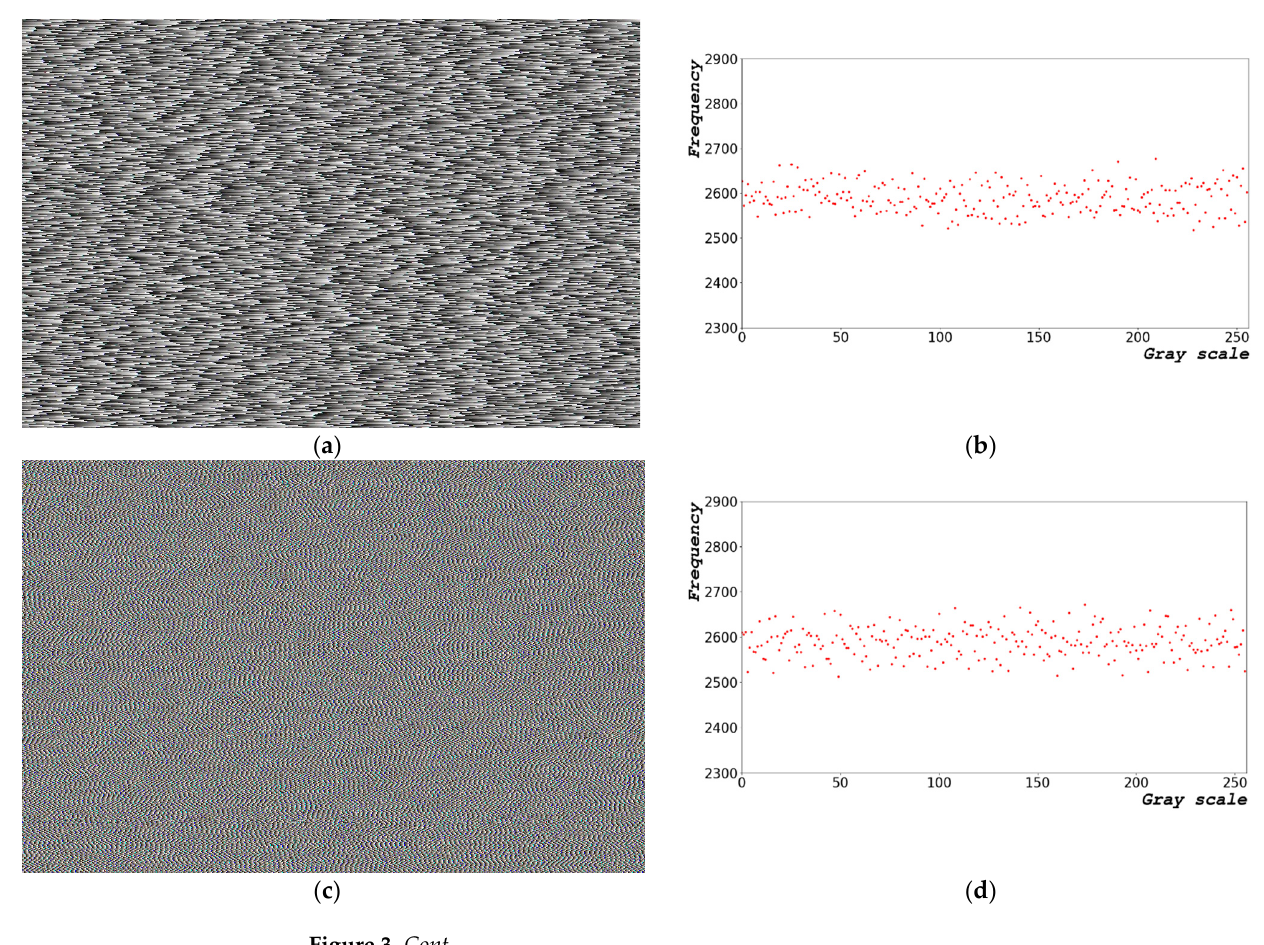
Table 3. Statistics data of Figure 2.